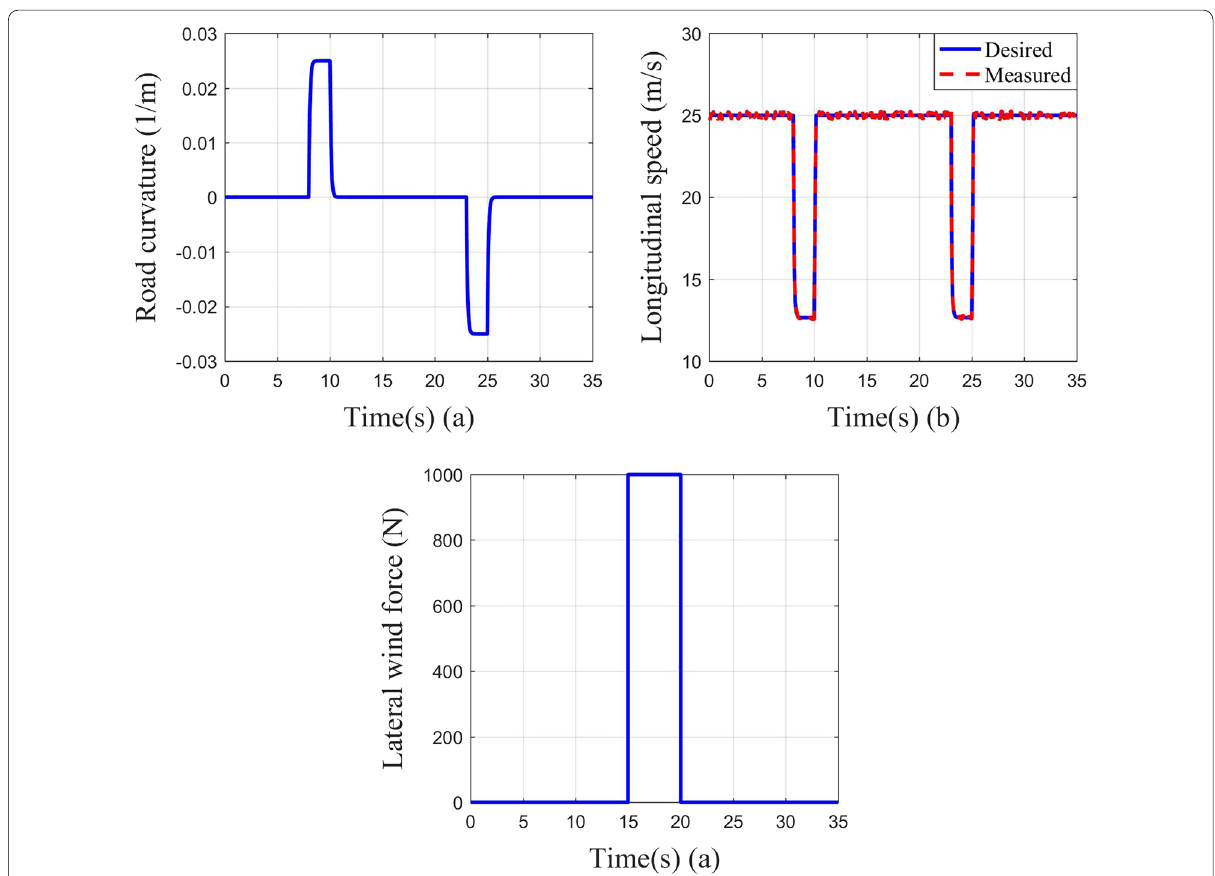
Figure 3 Given road curvature and the corresponding vehicle